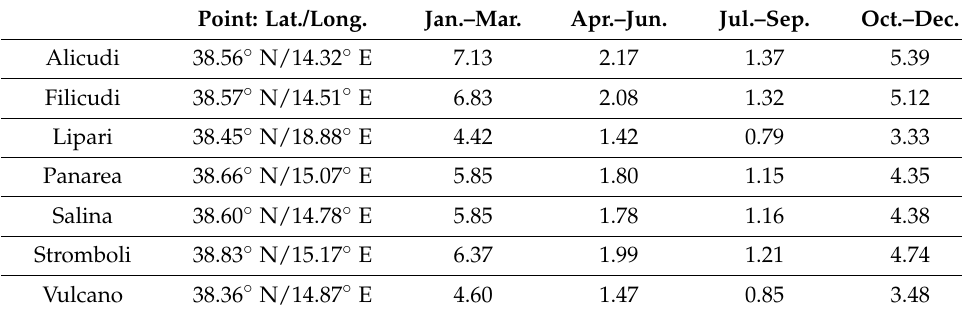
Table A7. Wave energy flux [kW/m] [51]. Point: Lat./Long.